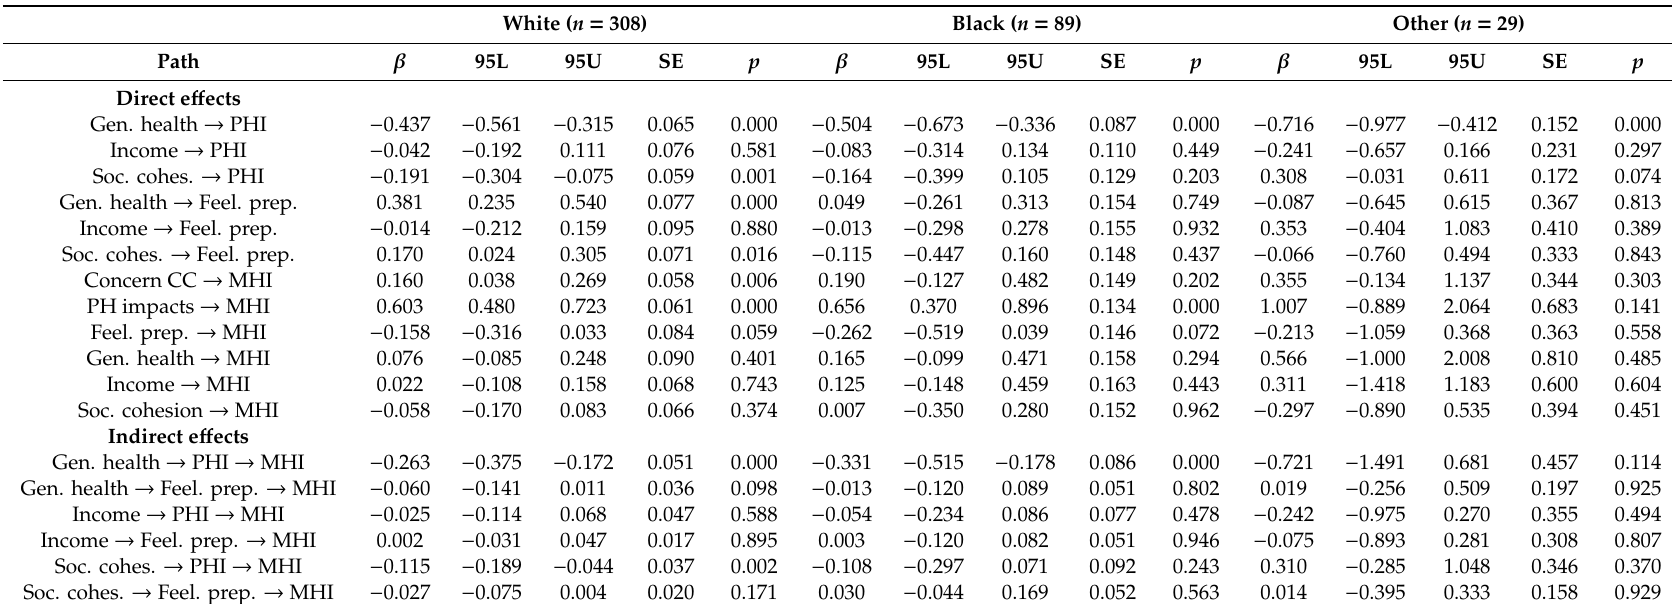
Table 6. Path analysis results for summer heat, by subgroup (N = 426).